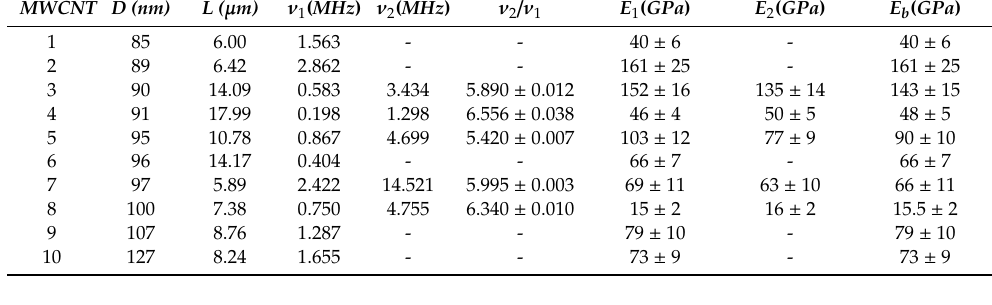
Table 2. Bending modulus of MWCNTs produced by chemical vapor deposition. E (cid:2869) is the bending modulus at the first mode and 𝐸 (cid:2870) is the bending at the second mode. The estimated experimental errors are ± 3 nm for 𝐷 , ± 200 nm for 𝐿 and ± 1 kHz for 𝜈 (cid:2869) and 𝜈 (cid:2870) . We neglect the inner diameter 𝐷 (cid:3036) for its contribution is very small for the MWCNTs studied here due to the 4th power dependence in the second moment of area: (𝐷 (cid:3036) 𝐷⁄ ) (cid:2872) ≪ 1 . The theoretical ratio equals 𝜈 (cid:2870) /𝜈 (cid:2869) = 𝛽 (cid:2870)(cid:2870) 𝛽 (cid:2869)(cid:2870) ⁄ = 6.267 . 𝐸 (cid:3029) specifies the weighted average of 𝐸 (cid:2869) and 𝐸 (cid:2870) .